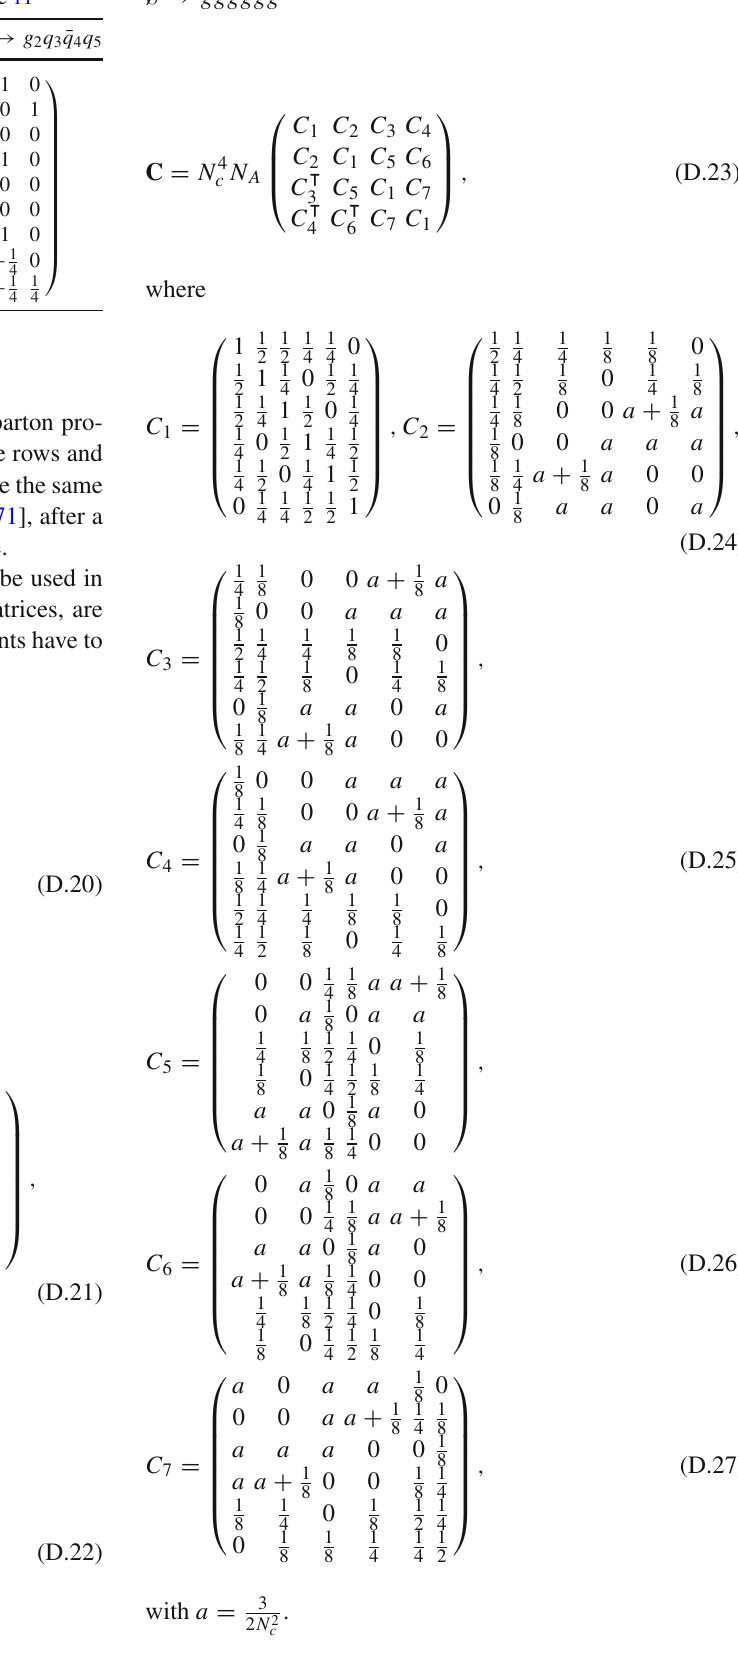
Table 16 The large N c limit of the matrices M from Table